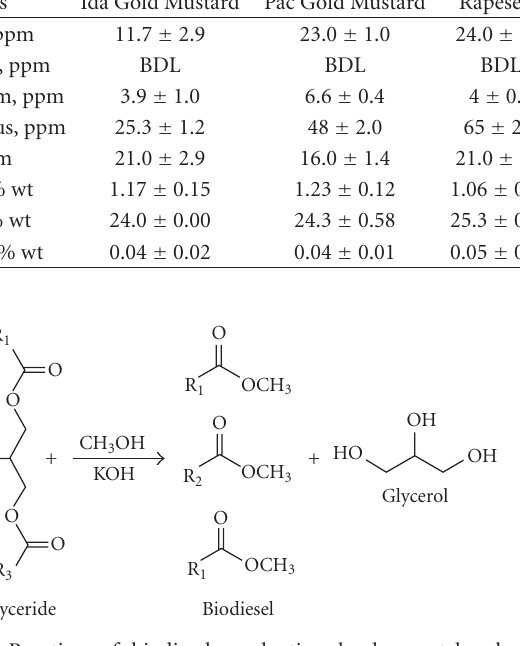
Figure 1: Reaction of biodiesel production by base-catalyzed transesterification with